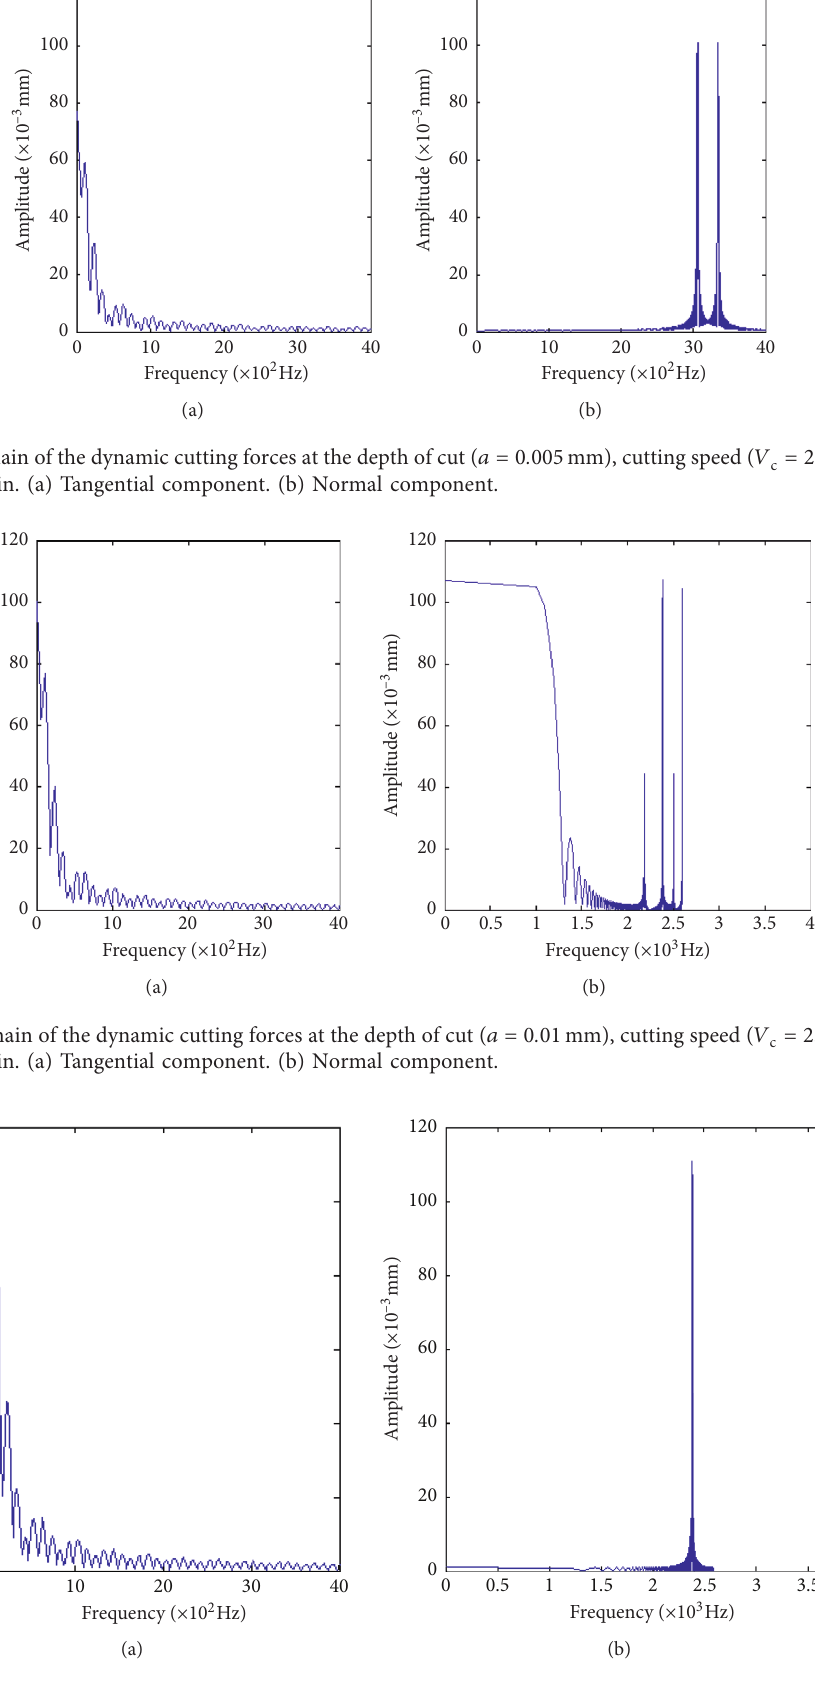
� 30m/s), and workpiece c